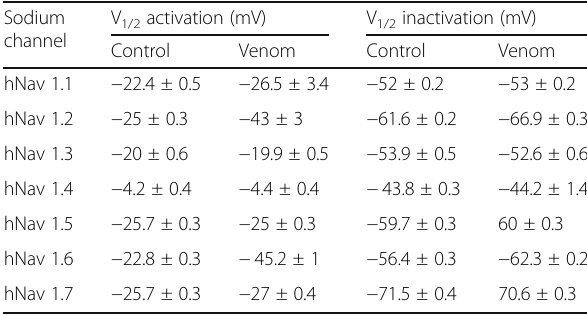
Table 2 Activation and inactivation V1/2